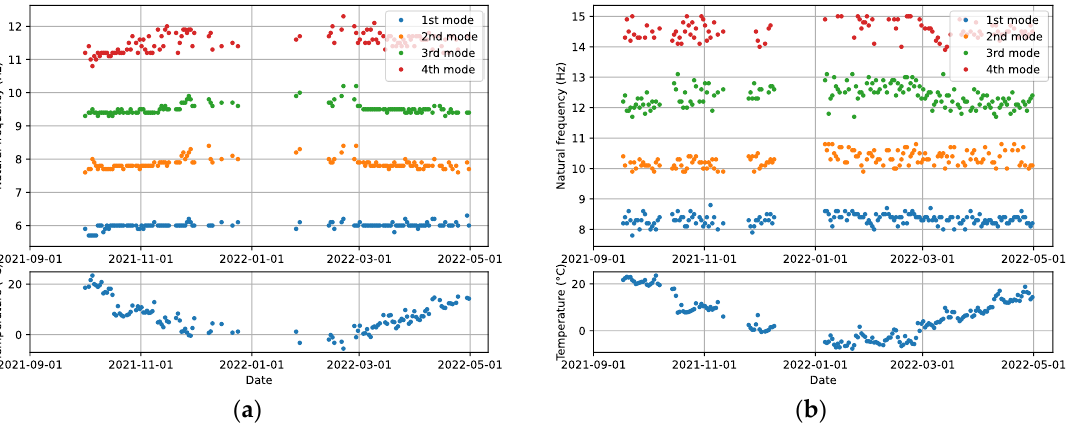
Figure 8. Daily variation patterns of natural frequencies: ( a ) Seolmun Bridge; ( b ) Gajwa Bridge.